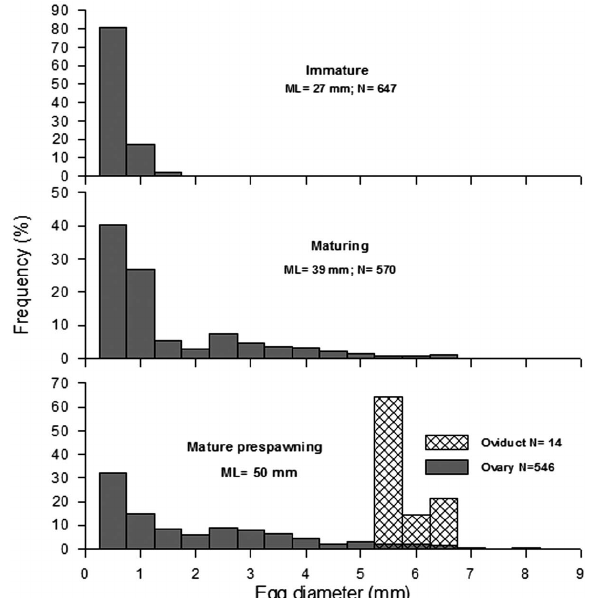
Fig. 5. – Size distribution of oocytes at different maturity stages of N.